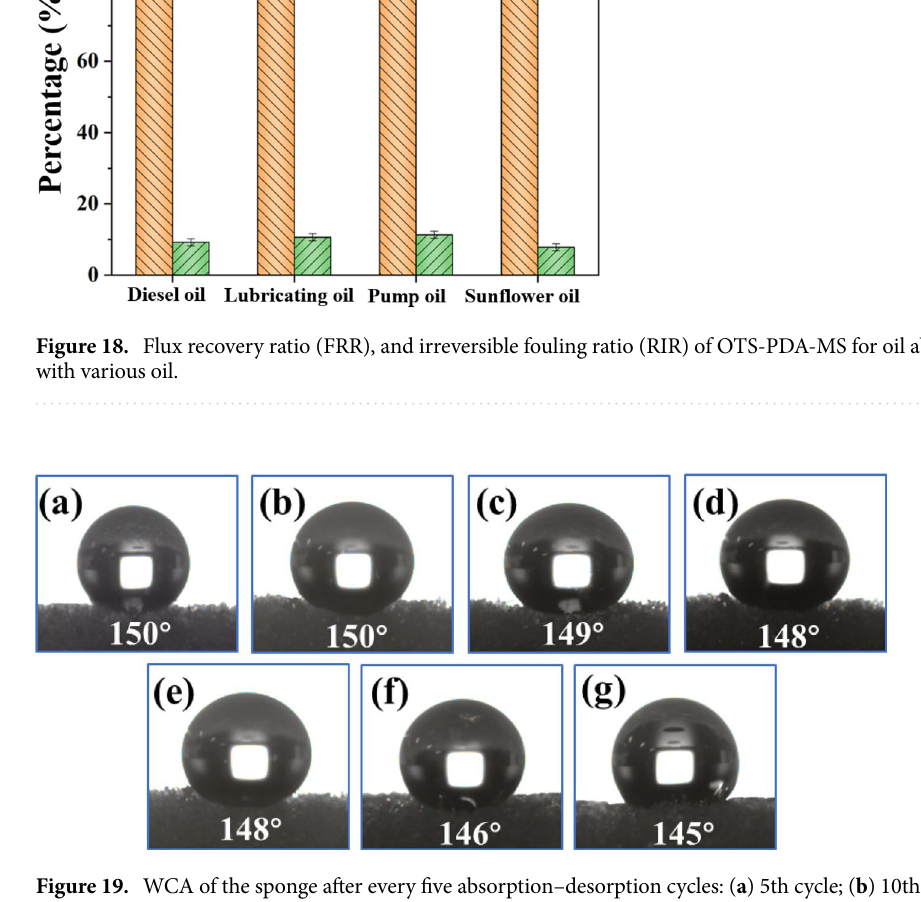
Figure 19. WCA of the sponge after every five absorption–desorption cycles: ( a ) 5th cycle; ( b ) 10th cycle; ( c ) 15th cycle; ( d ) 20th cycle; ( e ) 25th cycle; ( f ) 30th cycle; ( g ) 35th